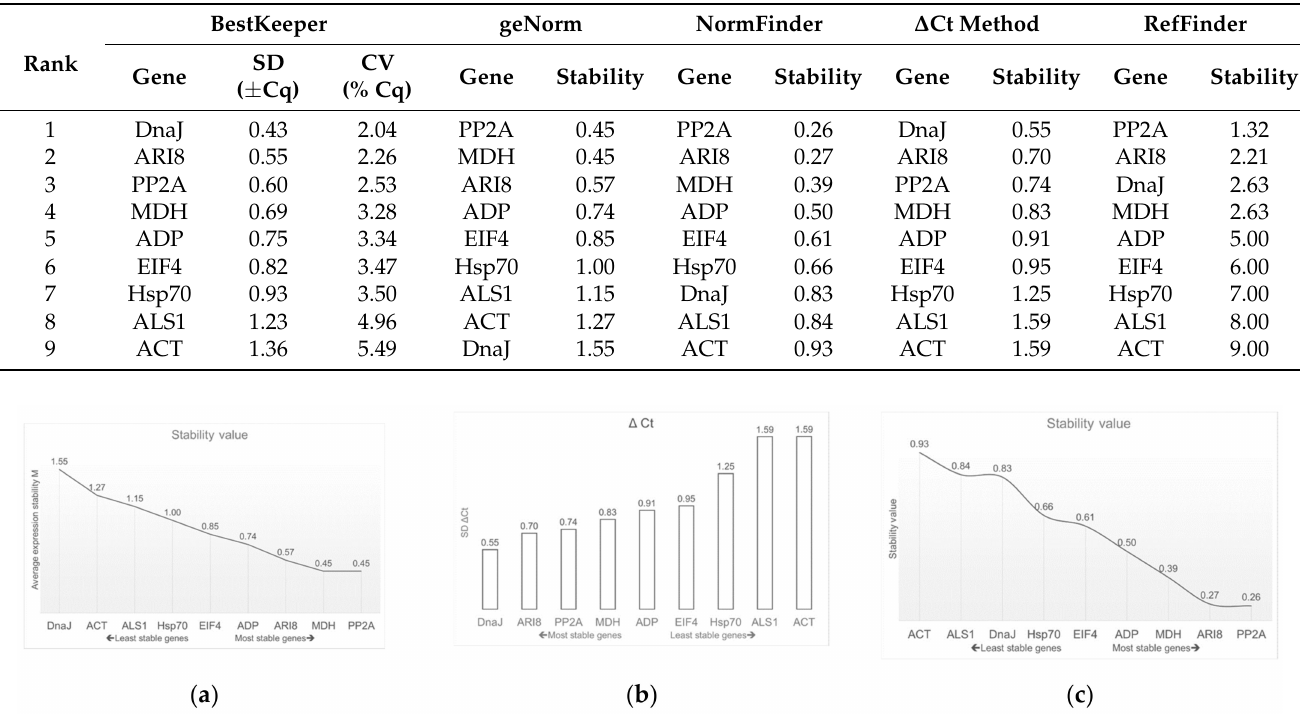
Figure 3. Expression levels of the nine candidate reference genes evaluated under glyphosate stress. Cycle threshold (Ct) values of the nine candidate reference genes in all samples. A line across the box value displays the median value of the Ct in the Box-plot graph. The lower and upper boxes indicate the 25th percentile to the 75th percentile, whereas the whiskers indicate the ranges for all samples. Table 2. Gene expression stability ranked by BestKeeper, geNorm, NormFinder, ∆ Ct method and RefFinder. SD ( ± Cq): standard deviation of the Cq; CV (% Cq): coefficient of variation expressed as percentage of the Cq level.